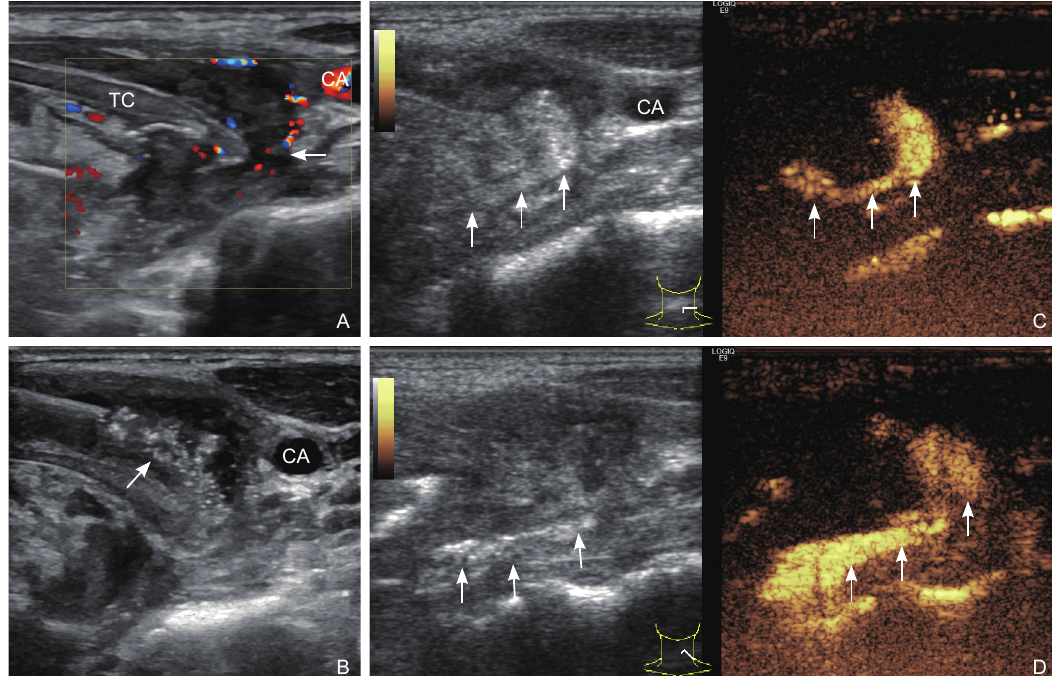
Figure 2 (A) The transverse image showing an abscess emerging from the posterolateral aspect of the thyroid cartilage (TC), which indicated that the abscess started from the pyriform sinus; (B) Injection of ultrasound contrast agent into the abscess. The images showing the fistula (C and D). TC, Thyroid cartilage; CA, Common carotid